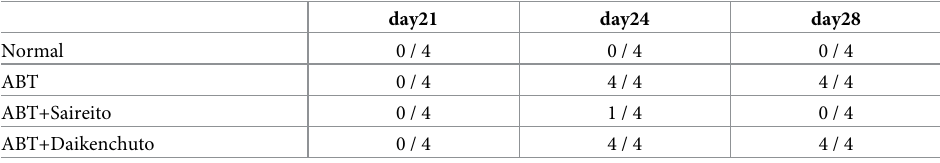
Table 1. Number of fecal occult bleeding positive